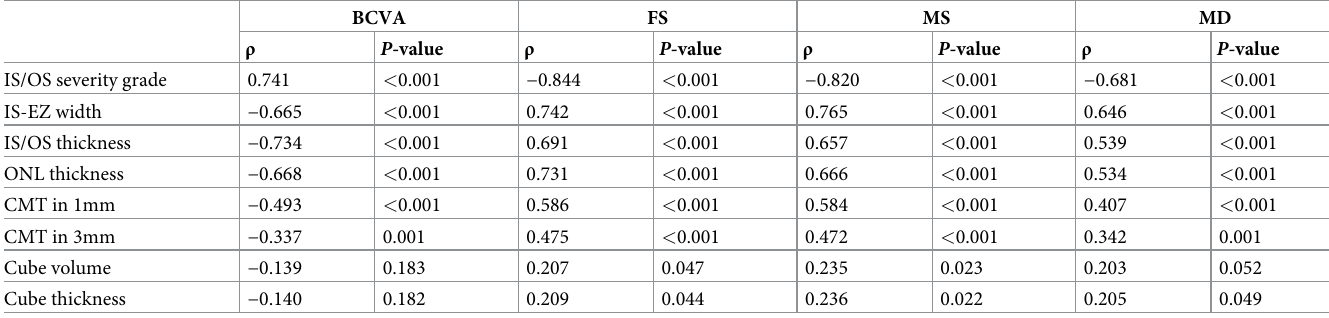
Table 2. Correlations between parameters of SD-OCT and central retinal